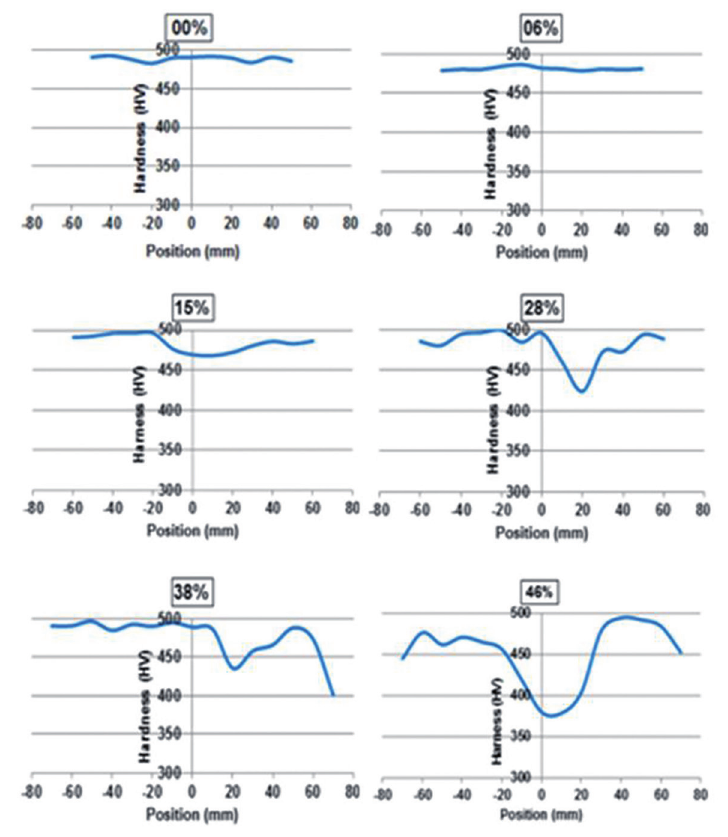
Figure 8: Hardness profiles along the test specimen for different axial deformations.